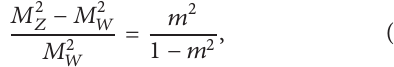
color: 𝑐 𝑘 = 𝑅, 𝐺, 𝐵 (“red, green, and blue”). In Table 1 we indicate the relevant quantum